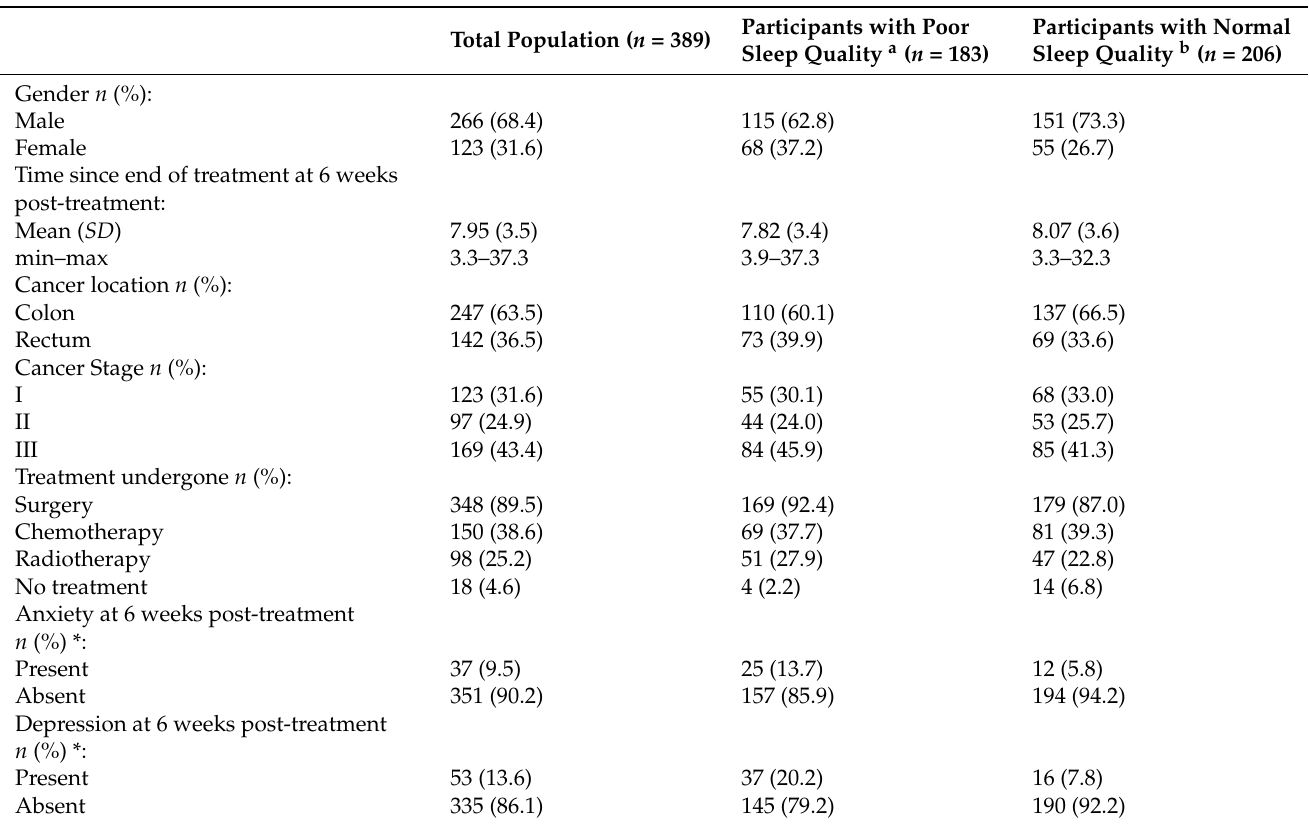
Participants with